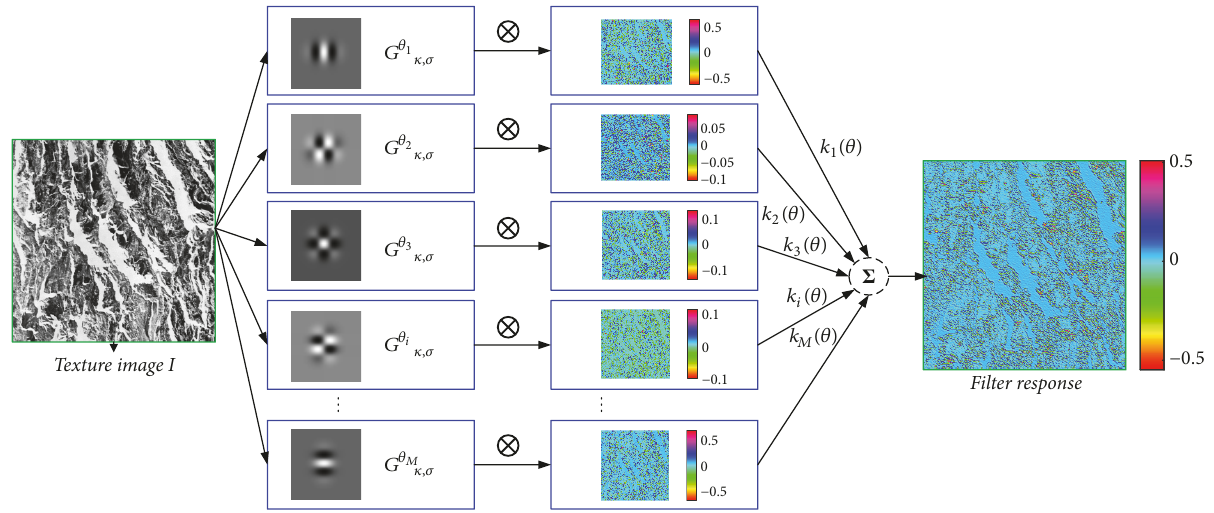
Figure 2: Computational schematic of the filtering response of SIGDF of a specific direction 𝜃